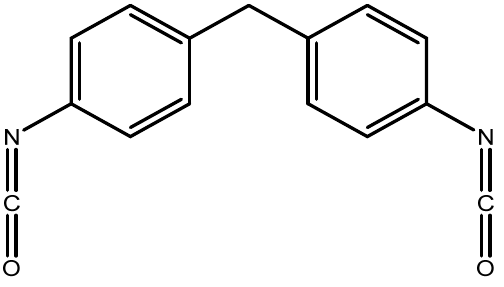
Figure 1. 4-4’-diphenylmethane diisocyanate . Figure 1. 4-4 (cid:48) -diphenylmethane